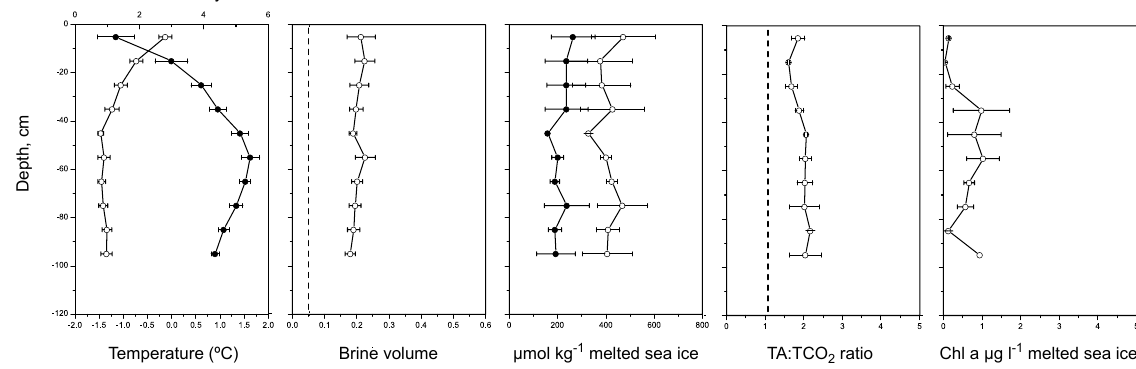
Fig. 2. Average conditions of temperature (open circles), bulk salinity (closed circles), brine volumes, TA (open circles), T CO 2 (closed circles), TA: T CO 2 ratio and Chl a at the coring site of the sea ice floe sampled during 22 to 30 June 2010. Values for temperature, salinity and brine volume are mean ± standard deviation ( n = 10) and for TA, T CO 2 , and Chl a ( n = 3).